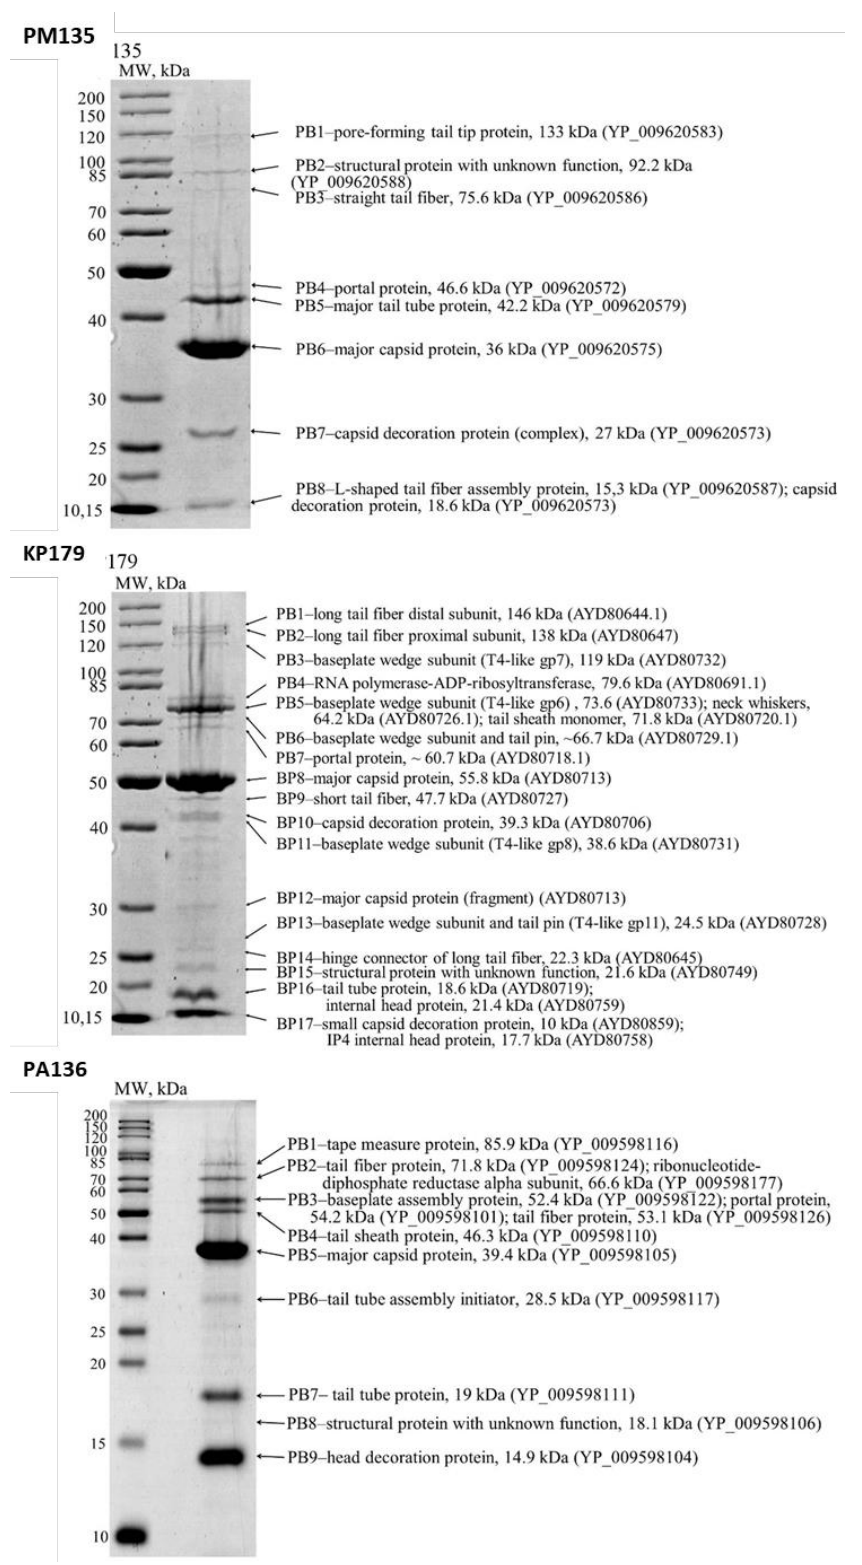
Figure 1. SDS-PAGEs of purified bacteriophage particles, followed by staining with Coomassie brilliant blue R250. The left lanes represent unstained protein standards (Thermo Fisher Scientific, Waltham, MA, USA). The names and molecular weights of the corresponding proteins are indicated on the right. GenBank identifiers for the sequences are shown in